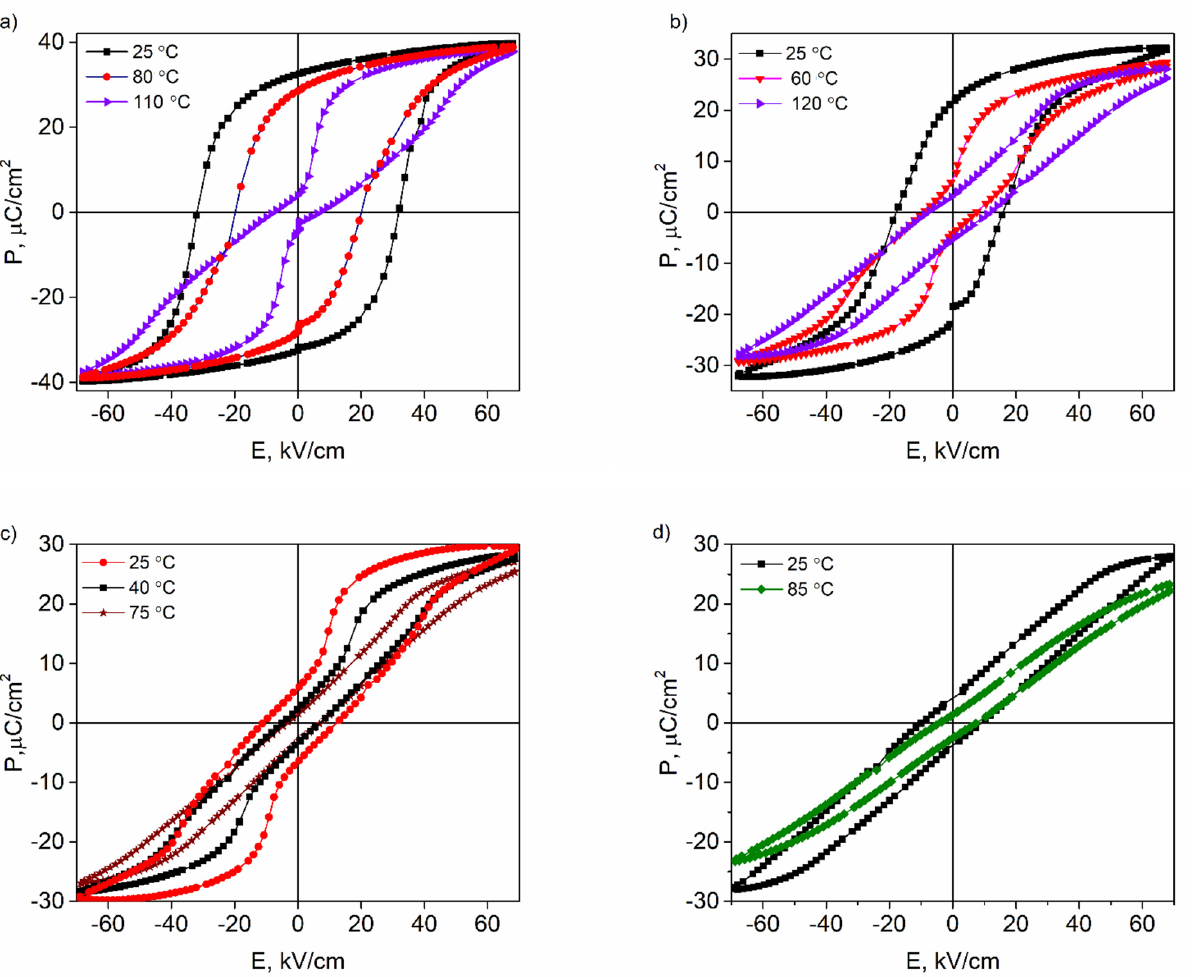
Figure 2. Polarization hysteresis loops at bipolar electric field pulses for (1 − x)(0.8NBT-0.2BT) − xCT compositions x = 0.050 ( a ), x = 0.075 ( b ), x = 0.100 ( c ), and x = 0.125 ( d ) at various temperatures.